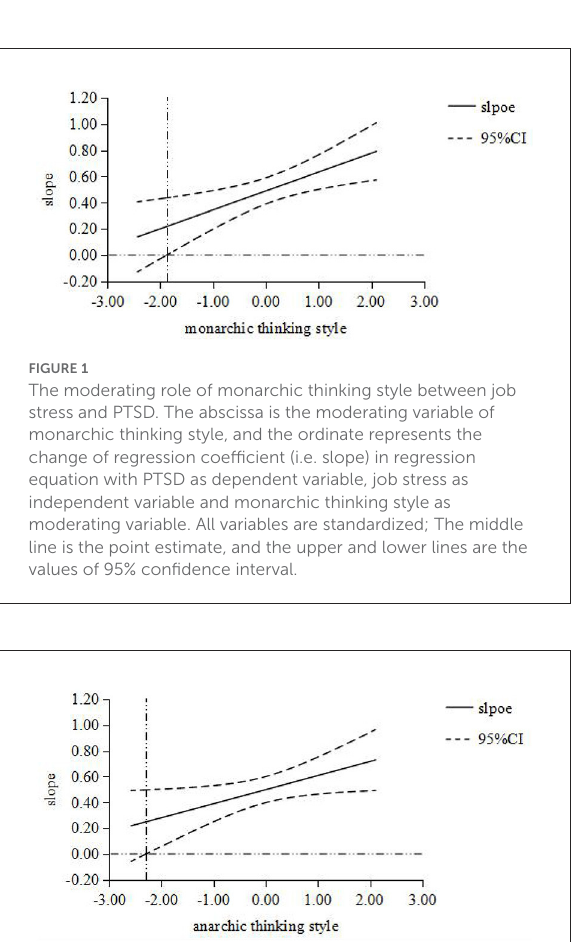
FIGURE2 The moderating role of anarchic thinking style between job stress and PTSD. The abscissa is the moderating variable of anarchic thinking style, and the ordinate represents the change of regression coefficient (i.e. slope) in regression equation with PTSD as dependent variable, job stress as independent variable and anarchic thinking style as moderating variable. All variables are standardized; The middle line is the point estimate, and the upper and lower lines are the values of 95% confidence interval.